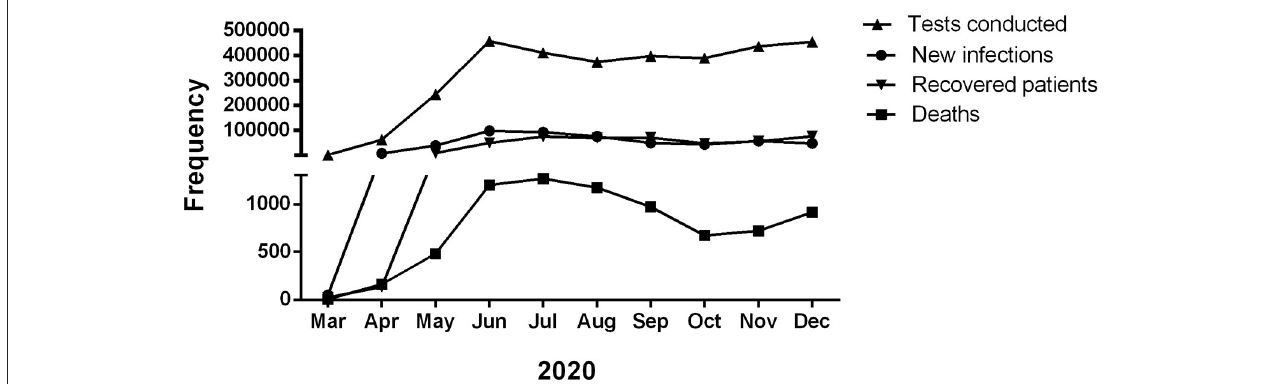
FIGURE 1 | Month-wise total number of COVID-19 patients, death, recovered, and RT-PCR test conducted in Bangladesh in 2020 (Ref: DGHS,